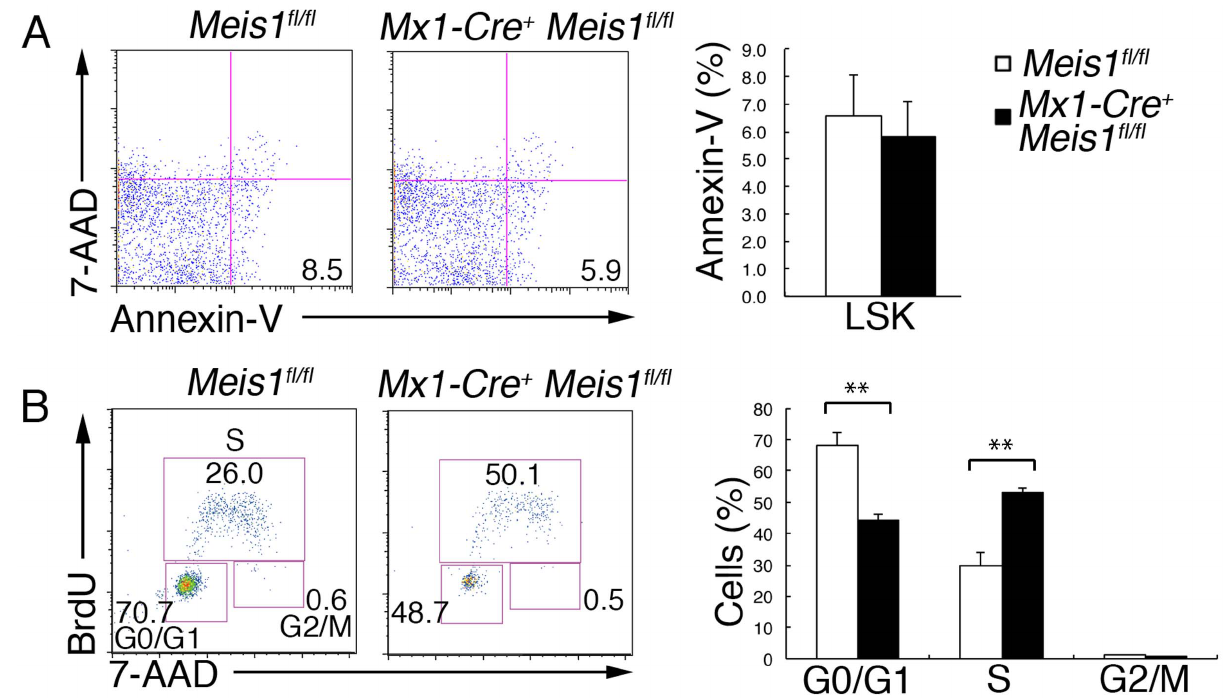
Figure 4. Meis1 regulates cell cycle of the HSC compartment. (A) Representative flow cytometric profiles showing Annexin V and 7-AAD staining of LSK cells from Mx1-Cre + Meis1 fl/fl and control mice one week after poly(I:C) treatment. Bar graphs on the right represent the percentages of apoptotic LSK cells (anexin V + 7-AAD 2 ) cells from poly(I:C)–treated Mx1-Cre + Meis1 fl/fl (solid bars) and control Meis1 fl/fl (open bars) mice (mean and SD; n=3). (B) Representative flow cytometric profiles showing BrdU incorporation and 7-AAD staining of LSK cells from Mx1-Cre Meis1 fl/fl and control mice one week after poly(I:C) treatment. Bar graphs shown on the right represent the percentages of cells in G0/G1-, S- and G2/M-phase of the cell cycle in the LSK cell population from poly(I:C)–treated Mx1-Cre + Meis1 fl/fl (solid bars) and control Meis1 fl/fl (open bars) mice (mean and SD; n=3). **p ,